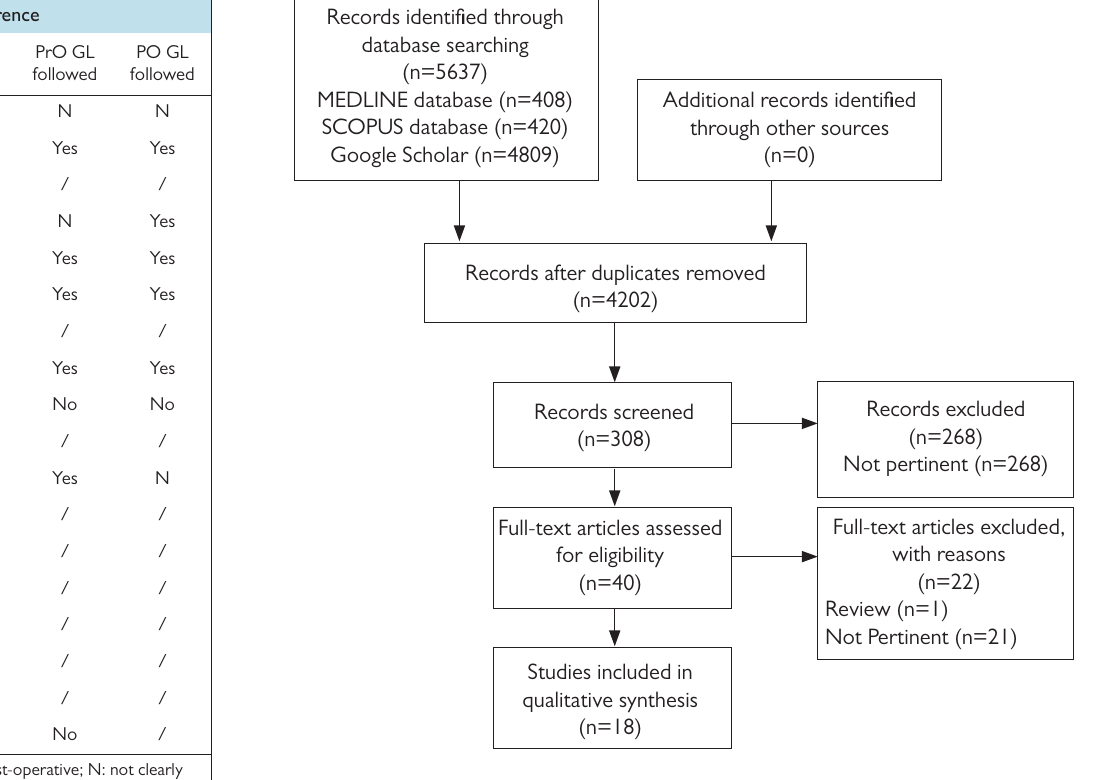
Figure 1. PRISMA